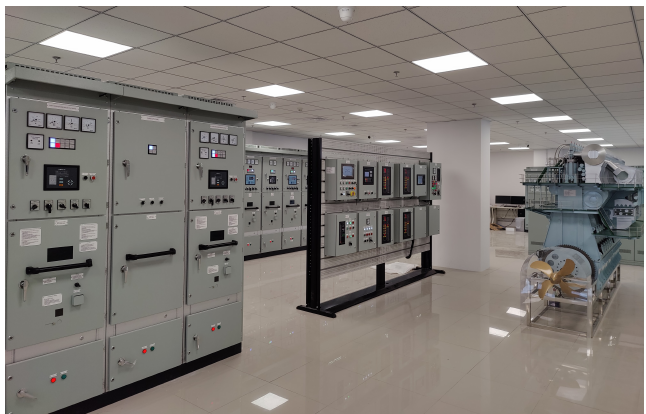
Figure 2. Semi-physical simulation